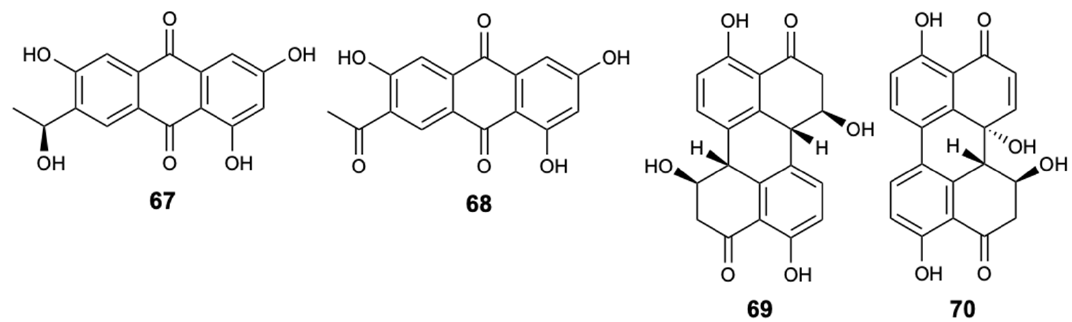
Figure 18. Structures of compounds 67 – 70 .